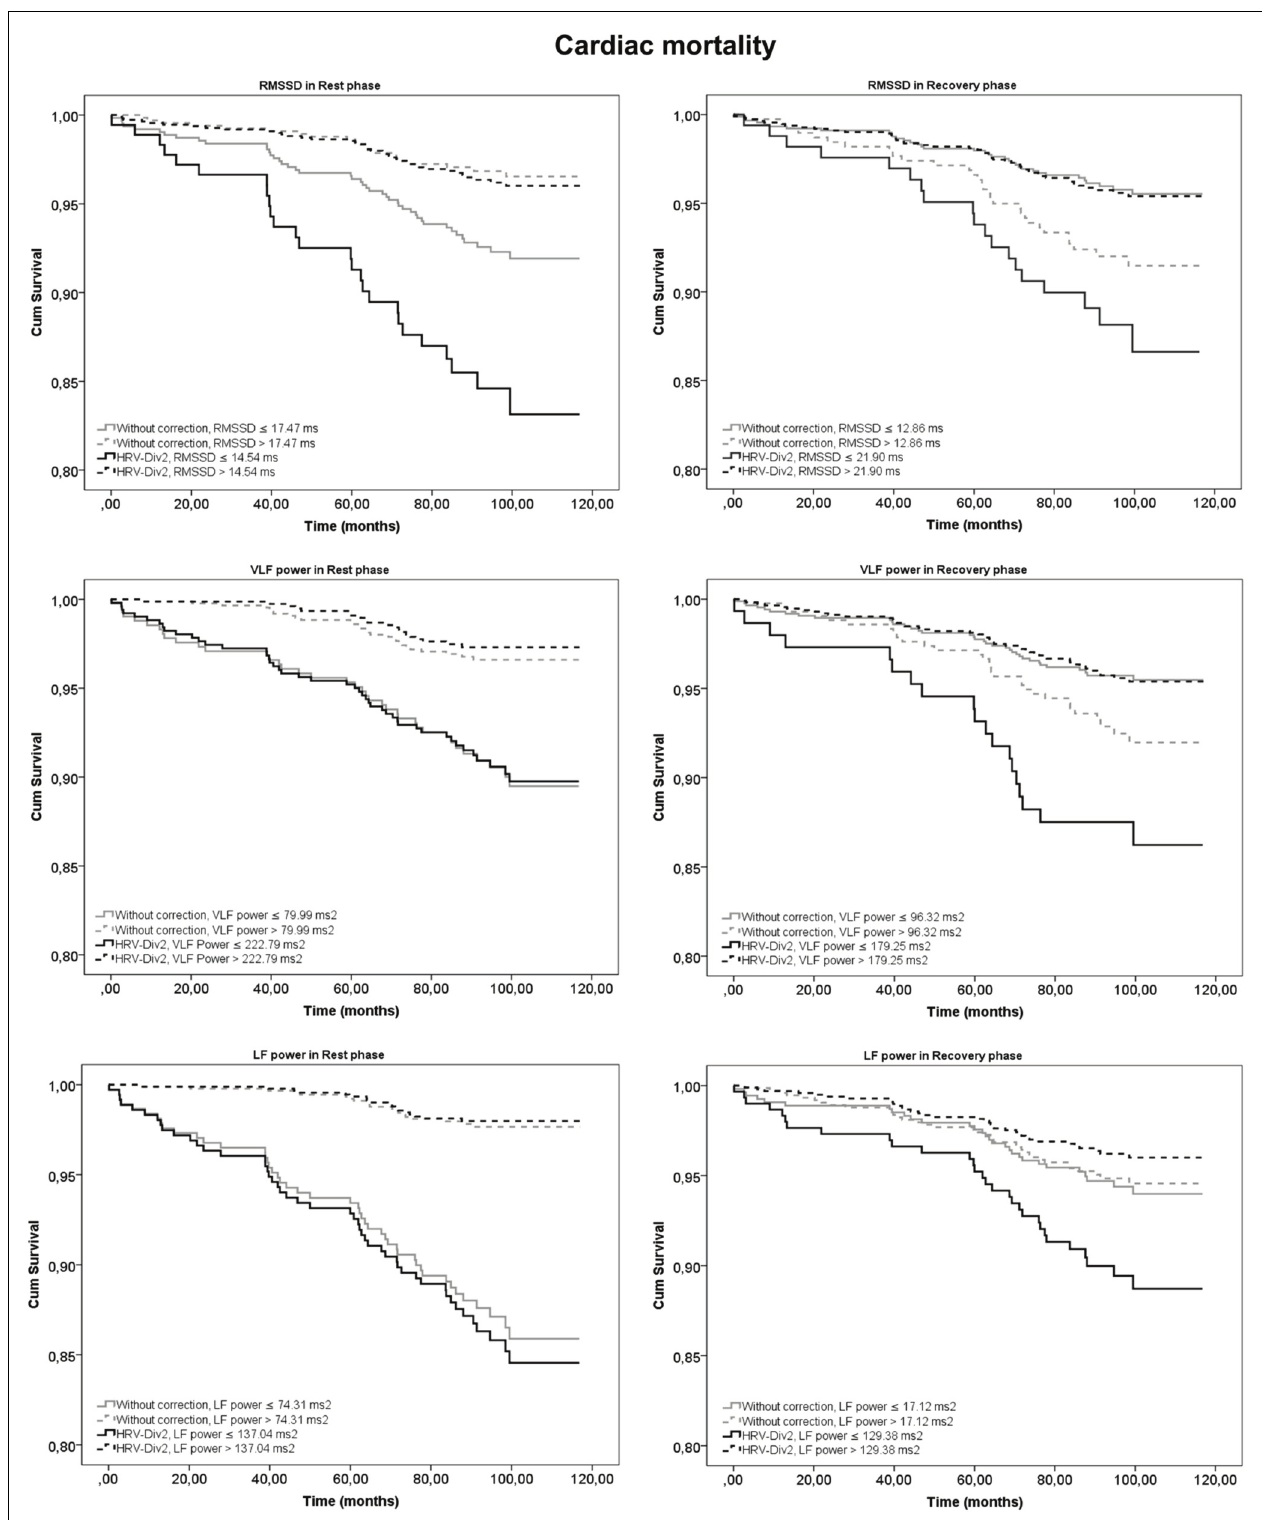
FIGURE 2 | Kaplan-Meier (KM) survival curves for prediction of cardiac mortality using heart rate variability (HRV) parameters at rest and recovery after exercise. Curves in gray represent HRV